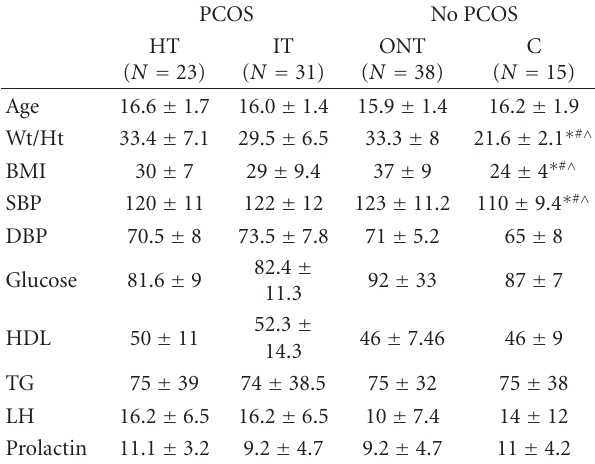
Table 1: Distribution of main metabolic parameters between